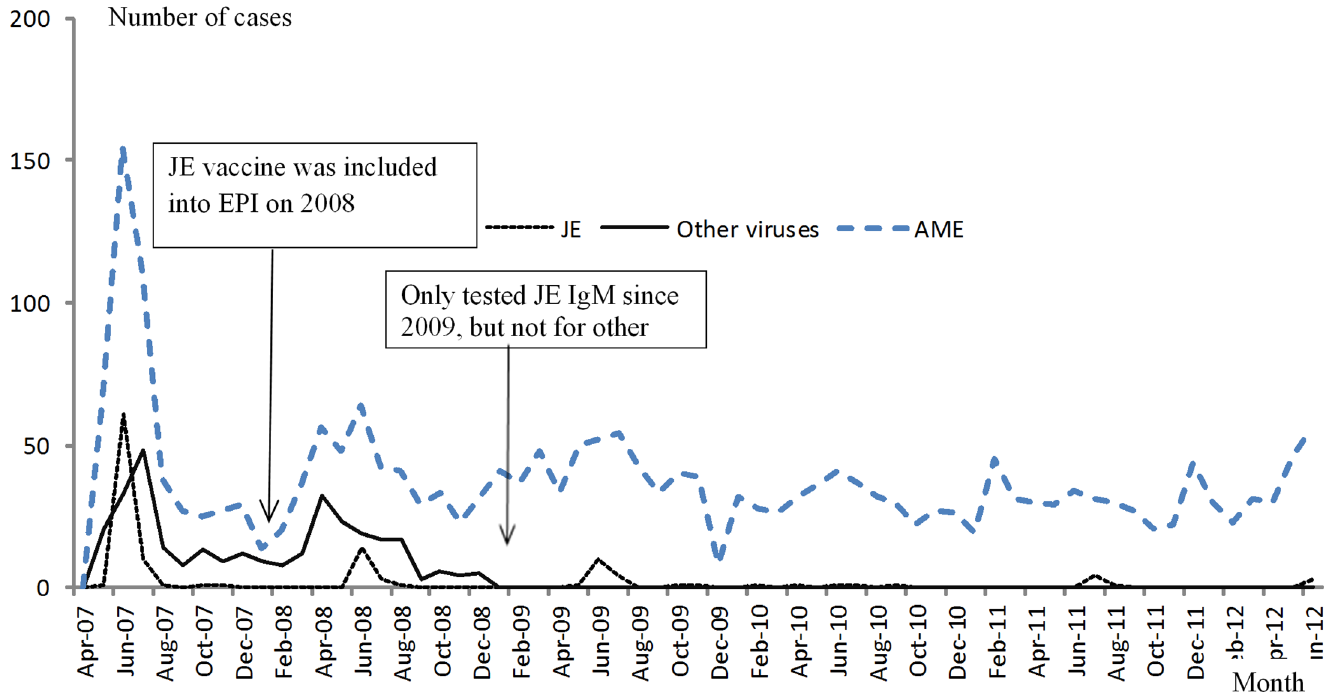
Fig 1. Monthly distribution of acute meningitis and encephalitis (AME) cases, Japanese encephalitis (JE) and other viruses in Guigang City, Guangxi, May 2007 — June 2012. * Only those cases with negative JE IgM results and onset between May 2007 and December 2008 were tested for other